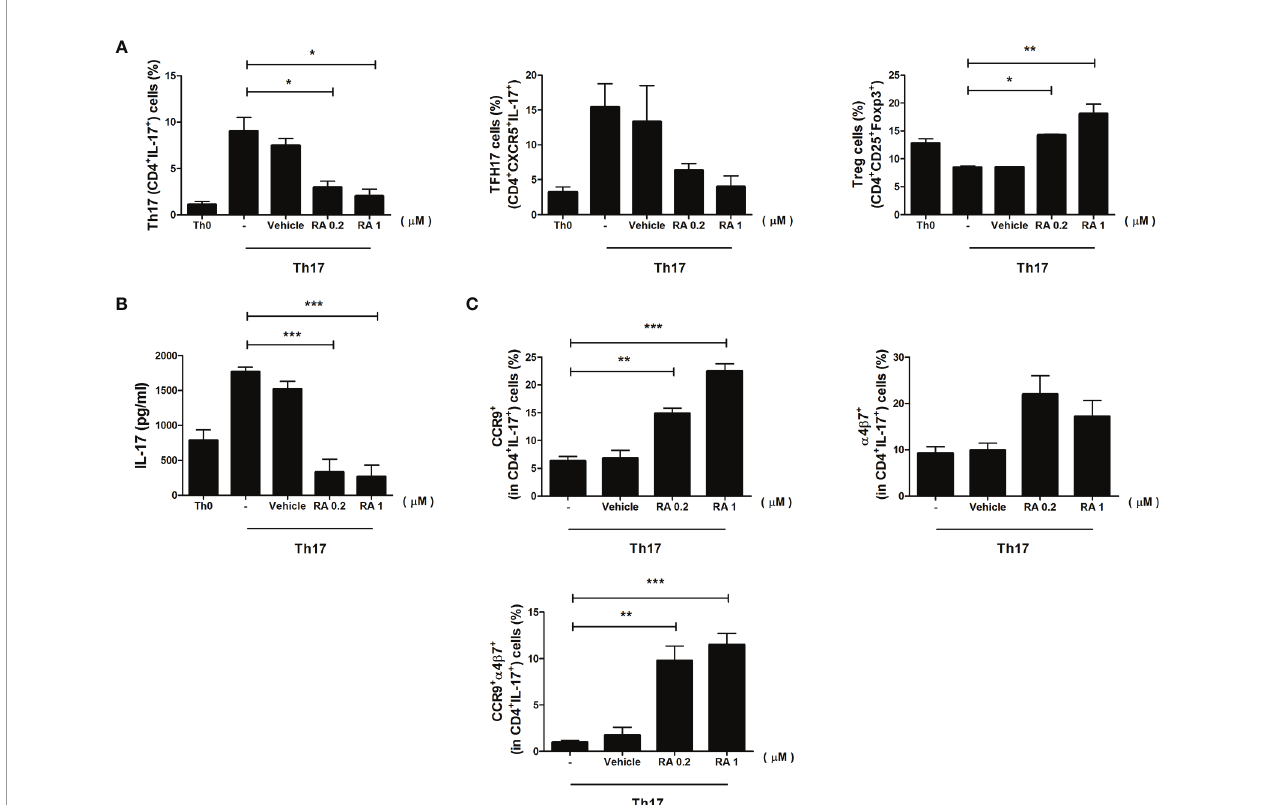
FIGURE 4 | The role of RA in the regulation of CD4+ T cells and gut-homing molecules. Splenic CD4 + T cells were isolated from NOD/ShitJ mice and then cultured under Th17 differentiation conditions with or without RA for 3 days. (A) Bar graphs show average frequencies of CD4 + IL-17 + (Th17), CD4 + CXCR5 + IL-17 + (T FH 17), and CD4 + CD25 + Foxp3 + (Treg) cells under the indicated conditions. (B) Bar graph shows average levels of secretory IL-17, as determined in the culture supernatant by enzyme-linked immunosorbent assay (ELISA) under the indicated conditions. (C) Bar graphs show average frequencies of CCR9 + (top and left), a 4 b 7 + (top and right), and CCR9 + a 4 b 7 + (bottom) in CD4 + IL-17 + cells under the indicated conditions. Data are means ± SEM from three independent experiments. * p < 0.05, ** p < 0.01, *** p <